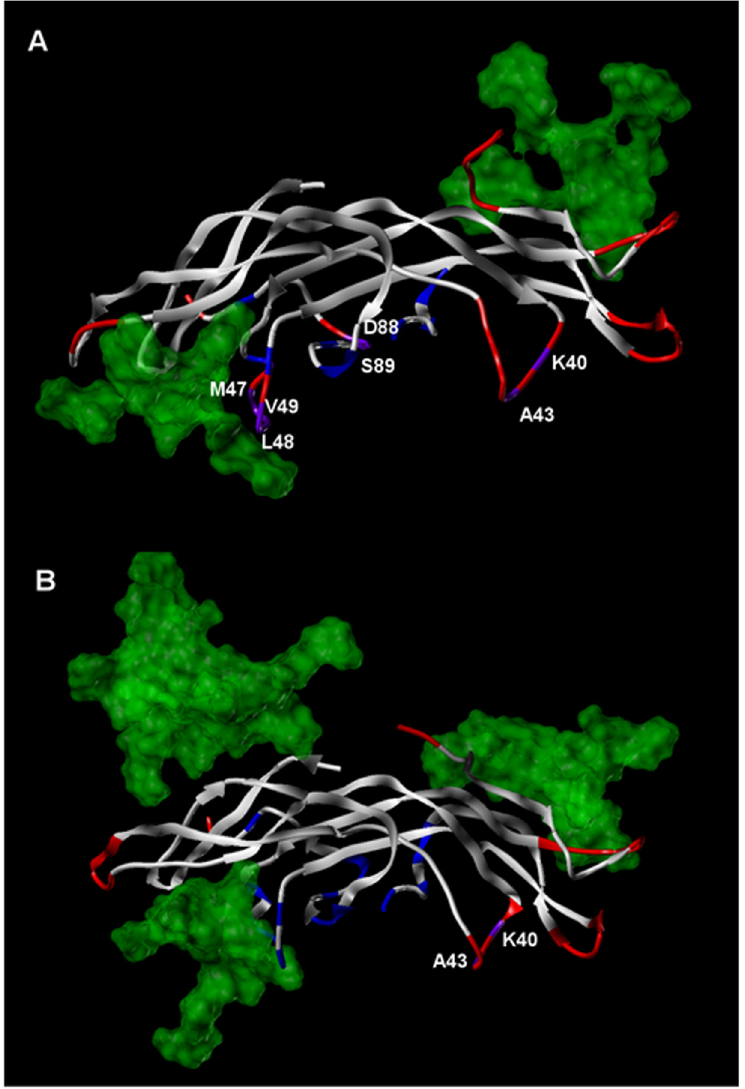
Fig 5. Comparison of FSH dynamic structural features at the FSH/FSHR interface for FSH(TAG) glycoforms. A. FSH 15 (TAG) and B. FSH 24 (TAG). The protein portion of FSH is rendered in ribbon form, while the spatial extent of TAG glycan residues is shown via transparent green features. FSH ribbons are colored as follows: blue = FSH residues with FSHR contact surfaces; red = FSH residues with backbone RMSD shifts of greater than 1.5 Å ; purple = FSH residues with FSHR contact surfaces and backbone RMSD shifts of greater than 1.5 Å